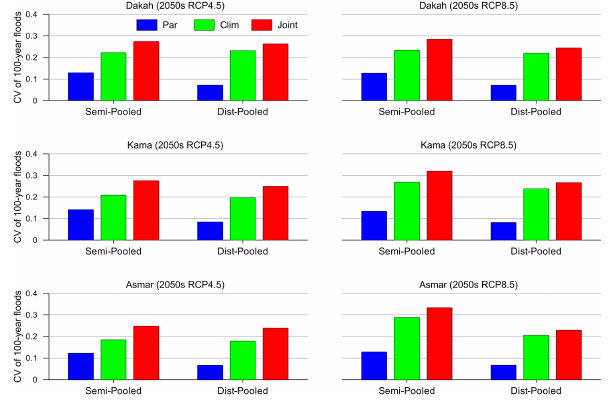
Figure 13. Uncertainties in 100-year daily flood estimates for 2050s are assessed using the Semi-Pooled and Dist-Pooled calibrations. Uncertainties are evaluated by calculating the CV of the 2050s 100- year flood estimates under three uncertainty sources: calibration uncertainty across 50 calibration trials (Par), climate uncertainty across GCM projections (Clim), and combined uncertainty